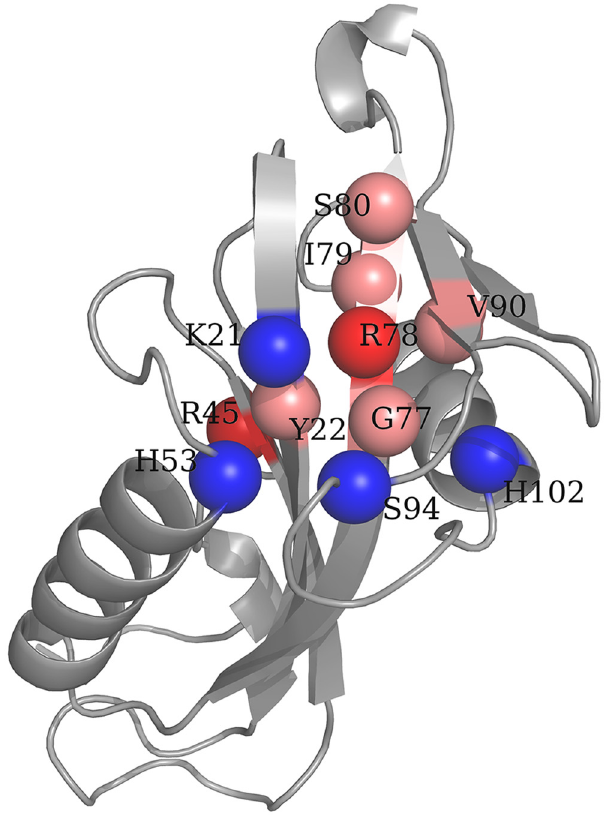
Fig 8. Ligand-free structure of PHPT1. Residues are colored as follows: Key position residues (pink), residues identified by UniProt[75] whose mutations affect the affinity for substrate and catalytic activity (blue), and key position residues identified also by Uniprot